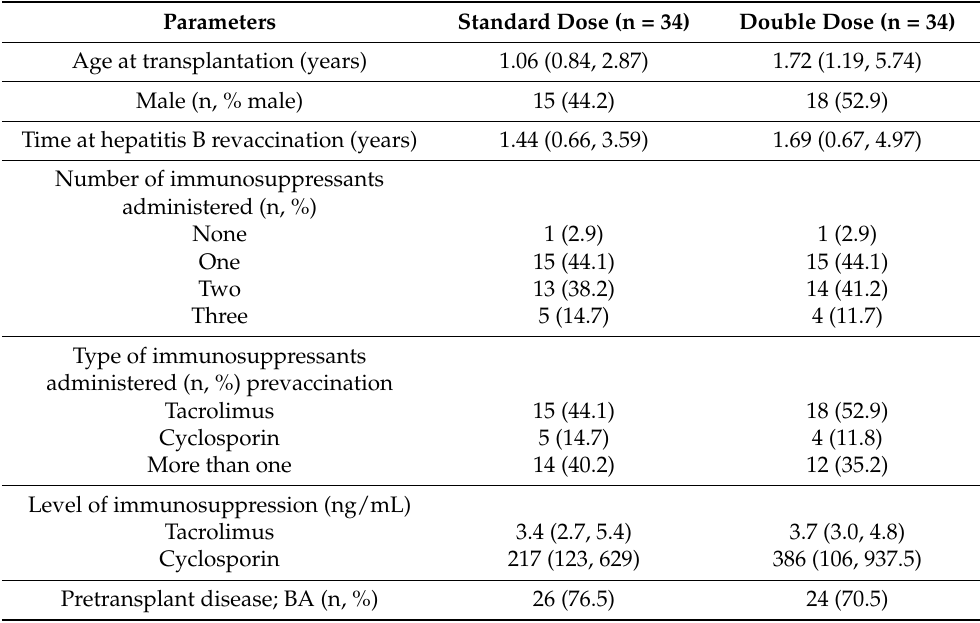
Table 1. Baseline patient characteristics before hepatitis B revaccination.